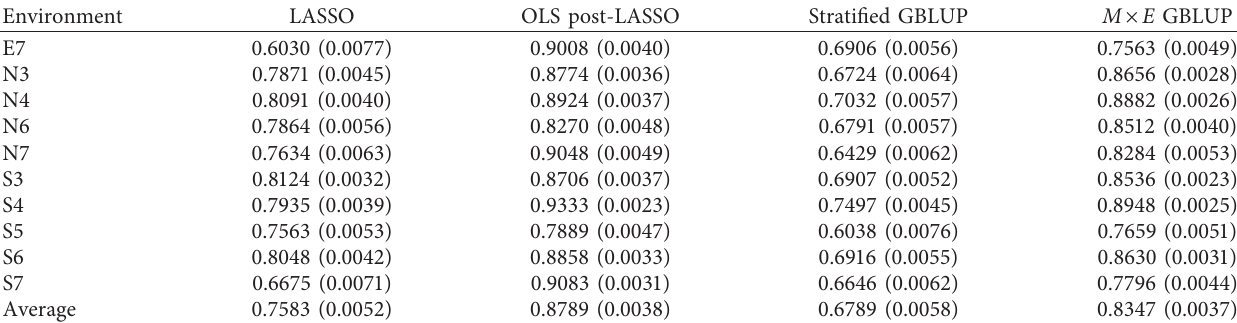
Table 3: The prediction accuracy (standard deviation, SD) of four methods for FT.